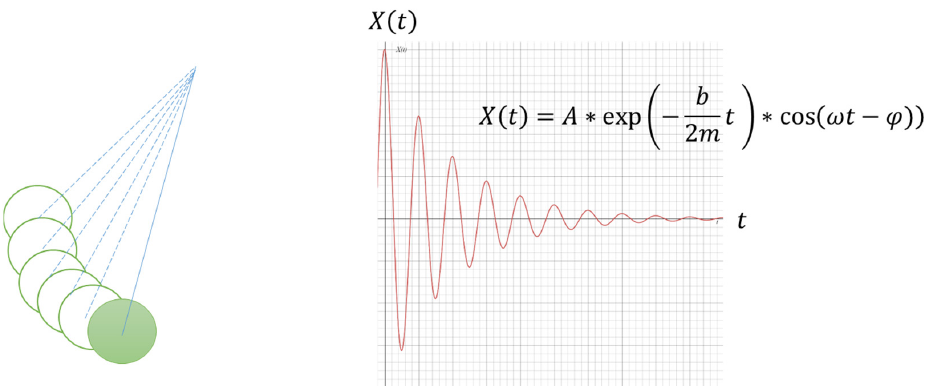
Figure 1. Pendulum Harmonic Motion.